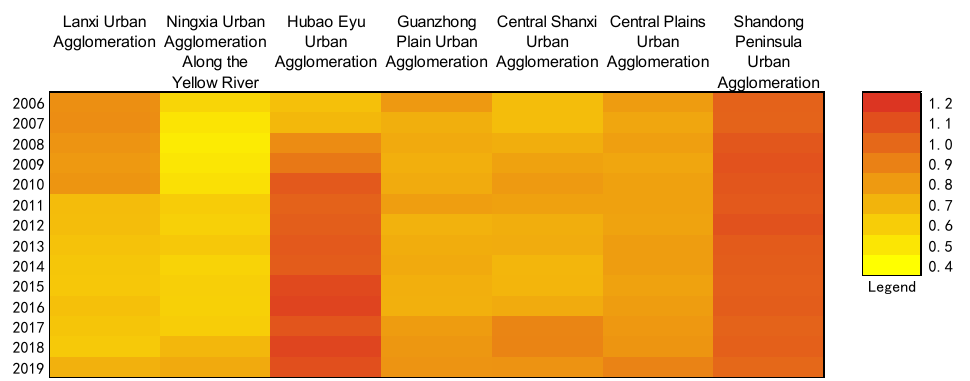
Figure 2. Heat map of urbanization efficiency of urban agglomerations in the Yellow River basin, China.